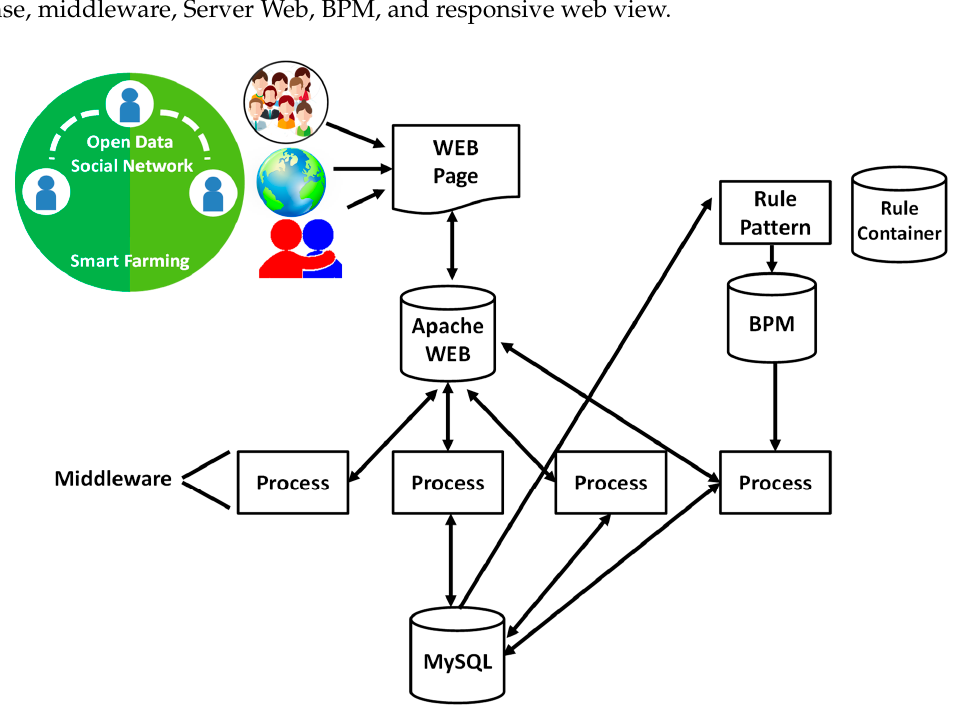
Figure 3. Farming SDS backend structure.